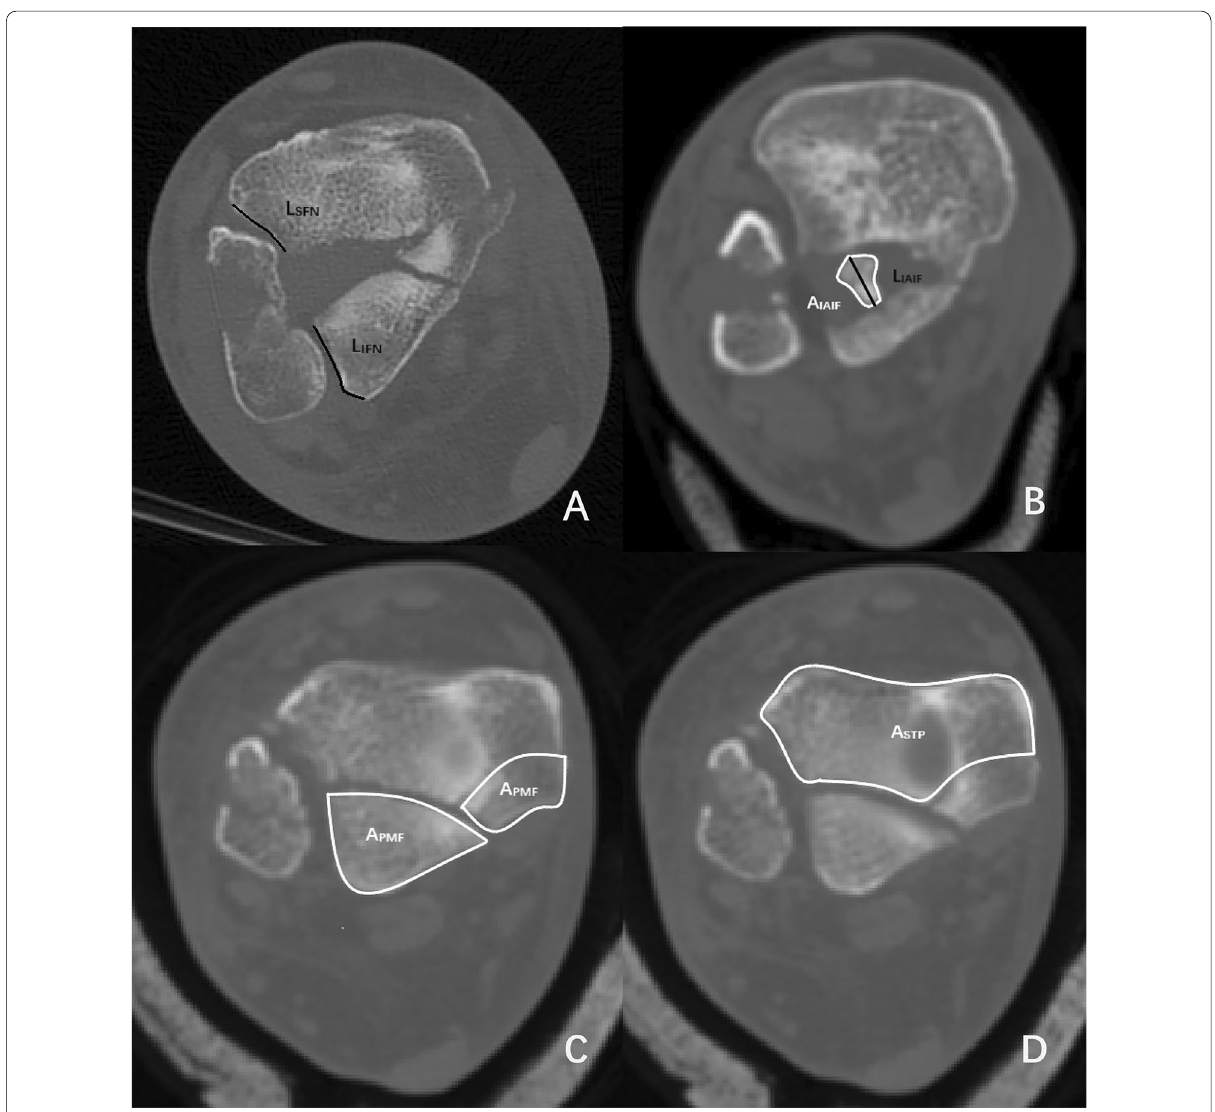
Fig. 1 Example axial CT cross-sectional measurements. A Measured as the length of involved fibular notch ( L IFN , length of involved fibular notch) and the stable fibular notch ( L SFN , length of stable fibular notch). B Measured as the length and area of IAIF ( L IAIF , length of IAIF, black; A IAIF , area of IAIF, white). C Measured as the area of posterior malleolar fragment ( A PMF , area of posterior malleolar fragment). D Measured as the area of stable tibial plafond ( A STP , area of stable tibial